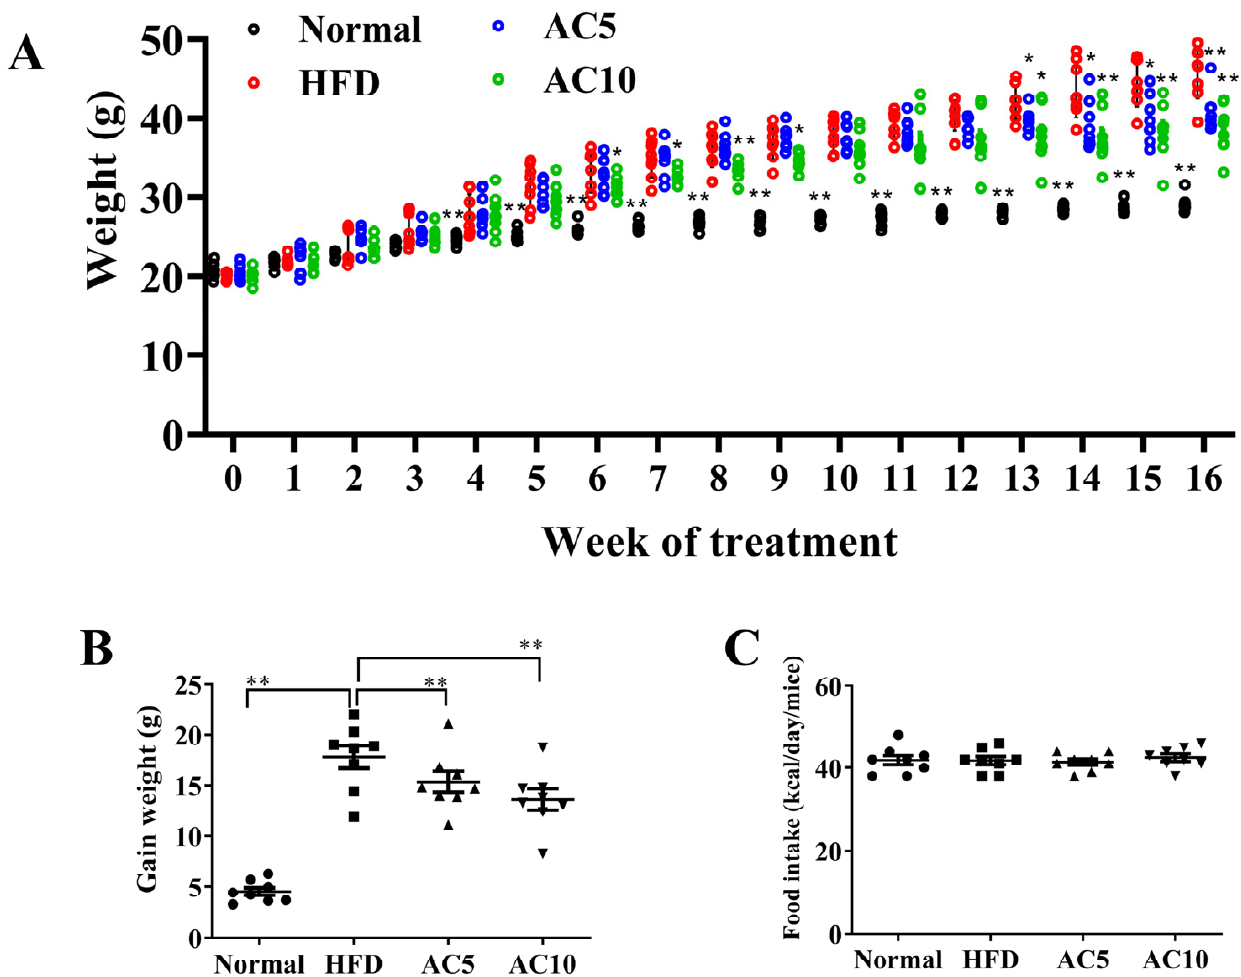
Figure 1. The biometrics of HFD-induced obese mice treated with acacetin (AC). ( A ) Body weight recorded weekly for 16 weeks. ( B ) The weight gain of HFD-induced obese mice that were treated with acacetin from week five to week 16. ( C ) Food intake recorded daily. The values are presented as mean ± SEM ( n = 8 per group). * p < 0.05, ** p < 0.01 compared to HFD group.